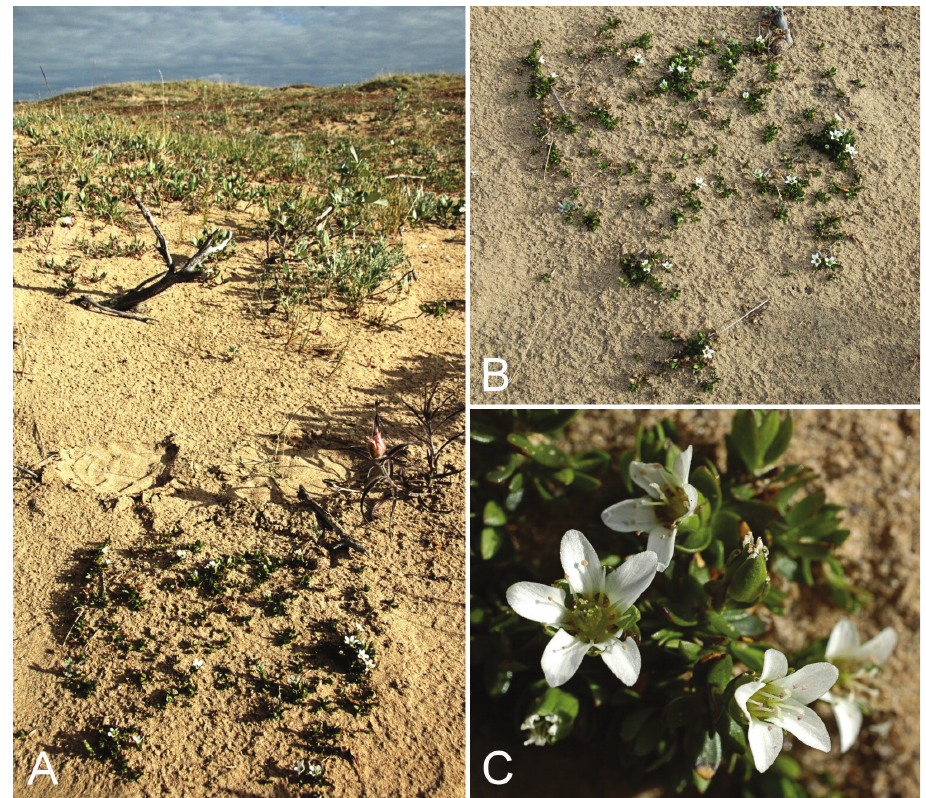
Figure 12. Arenaria humifusa : A habitat B habit C flowers, Gillespie et al. 9882 . Photographs by L.J.